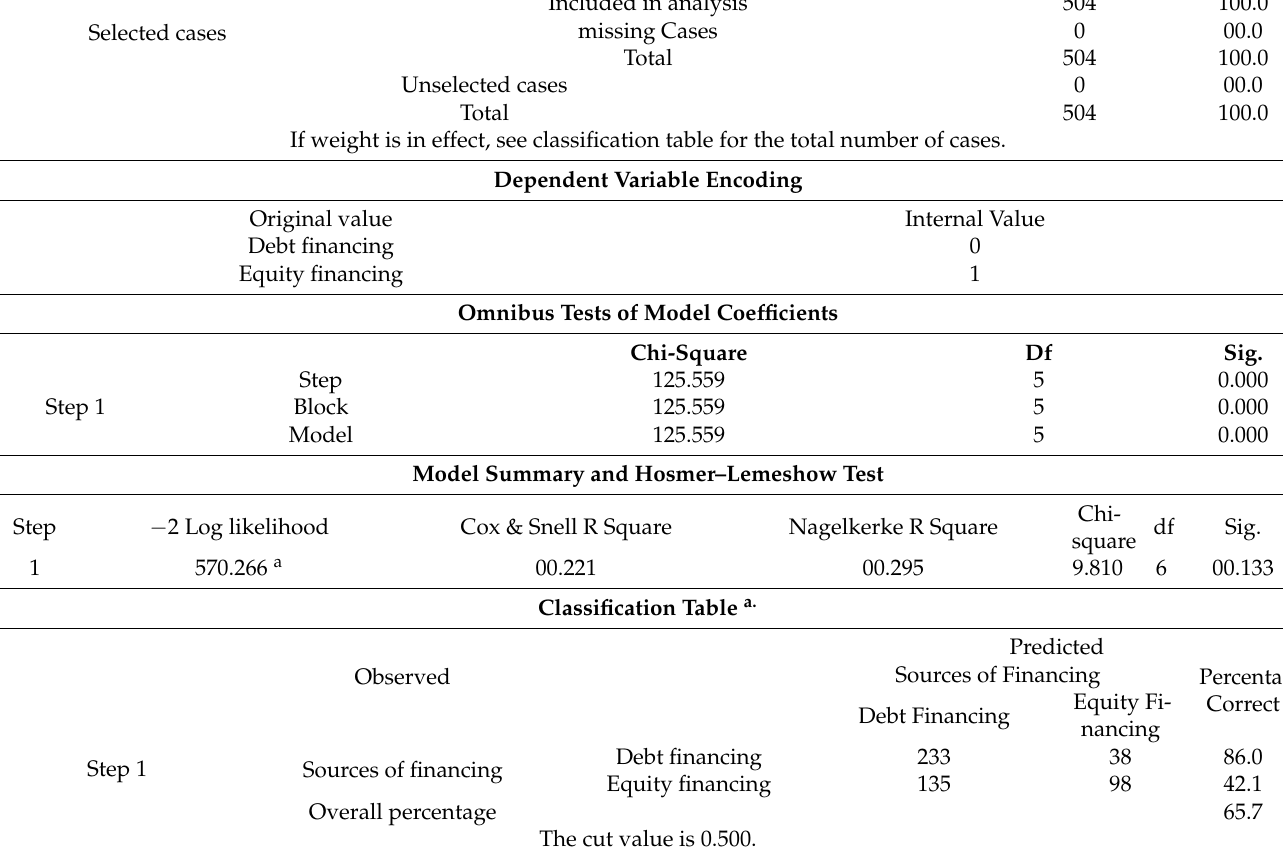
Classification Table